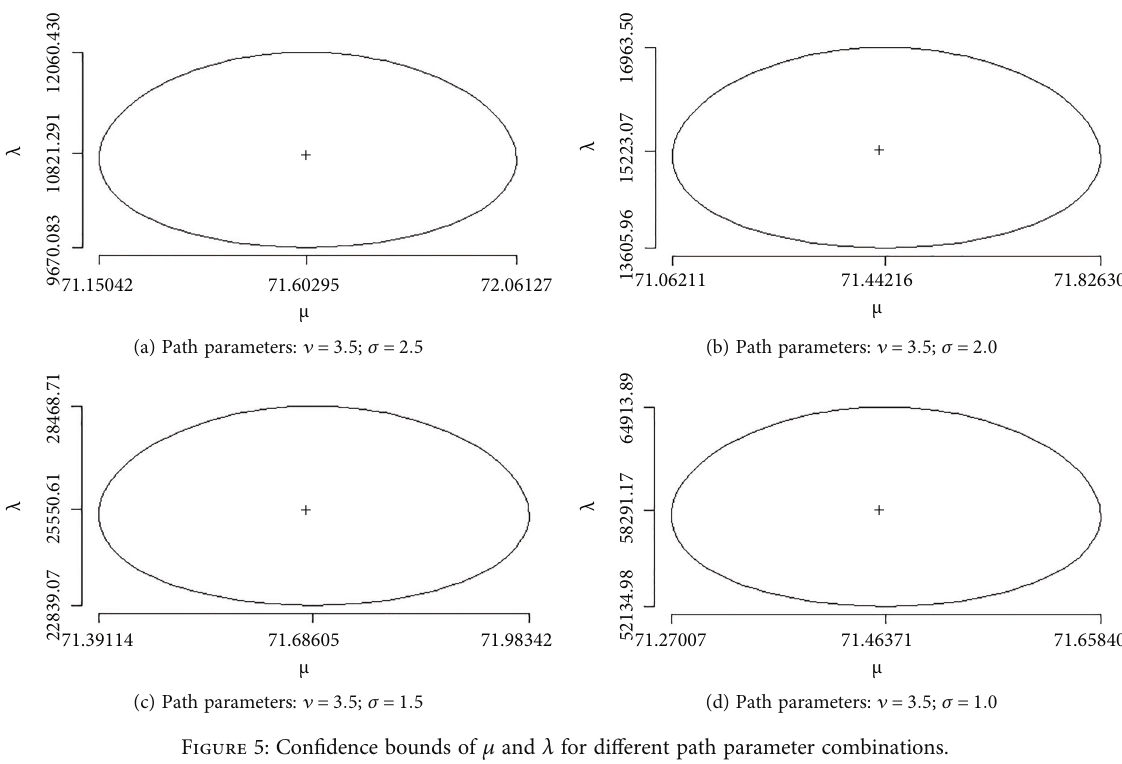
Figure 5: Con fi dence bounds of μ and λ for di ff erent path parameter